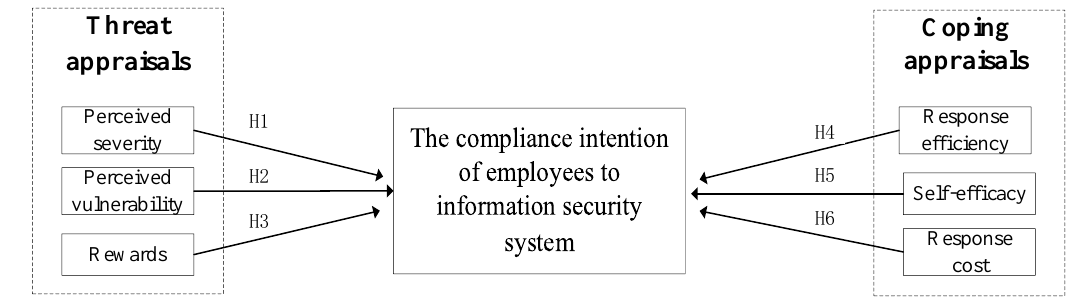
Figure 1. Model of the research hypotheses.